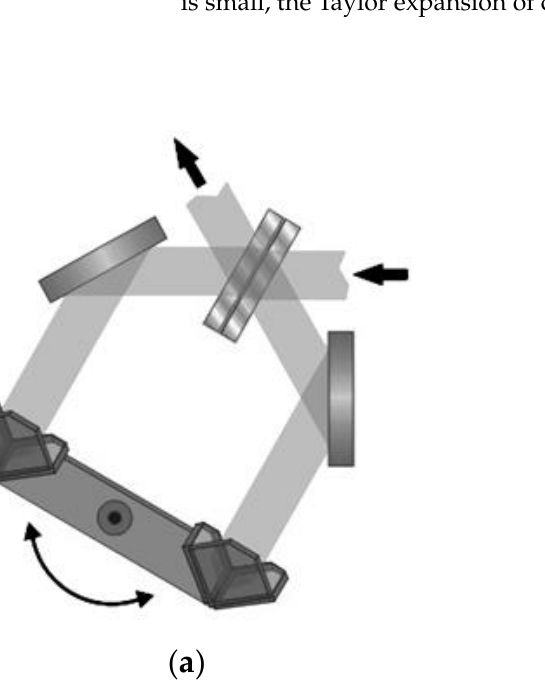
Figure 4. The relationship between the angular velocity and the time of the RT VCM. Combined with sinusoidal commutation, in this study, we designed the speed curve of the RT VCM such that the angular speed curve was as smooth as possible. According to the performance parameters in Table 1, the relationship between the angular speed and the time of the RT VCM finally determined is shown in the red curve in Figure 5, in which the blue curve represents the angular speed without sinusoidal com- mutation. The relationship between the angular displacement and the time corresponding to the angular velocity is shown in Figure 6. Table 1. The performance index of the moving mirror control system. Parameter